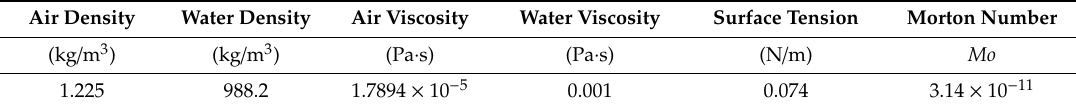
Table 1. The physical parameters.